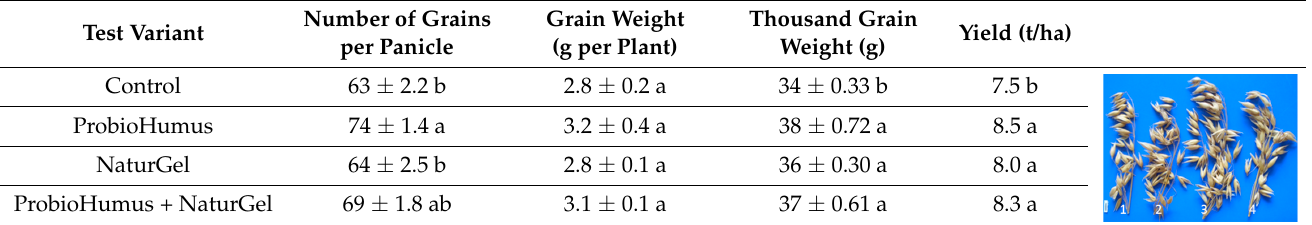
Table 5. Effect of probiotic preparations on oat panicle growth and grain yield at maturity stage. The photo shows the effect of probiotics on the development of oat panicles: 1. Control; 2. NaturGel;